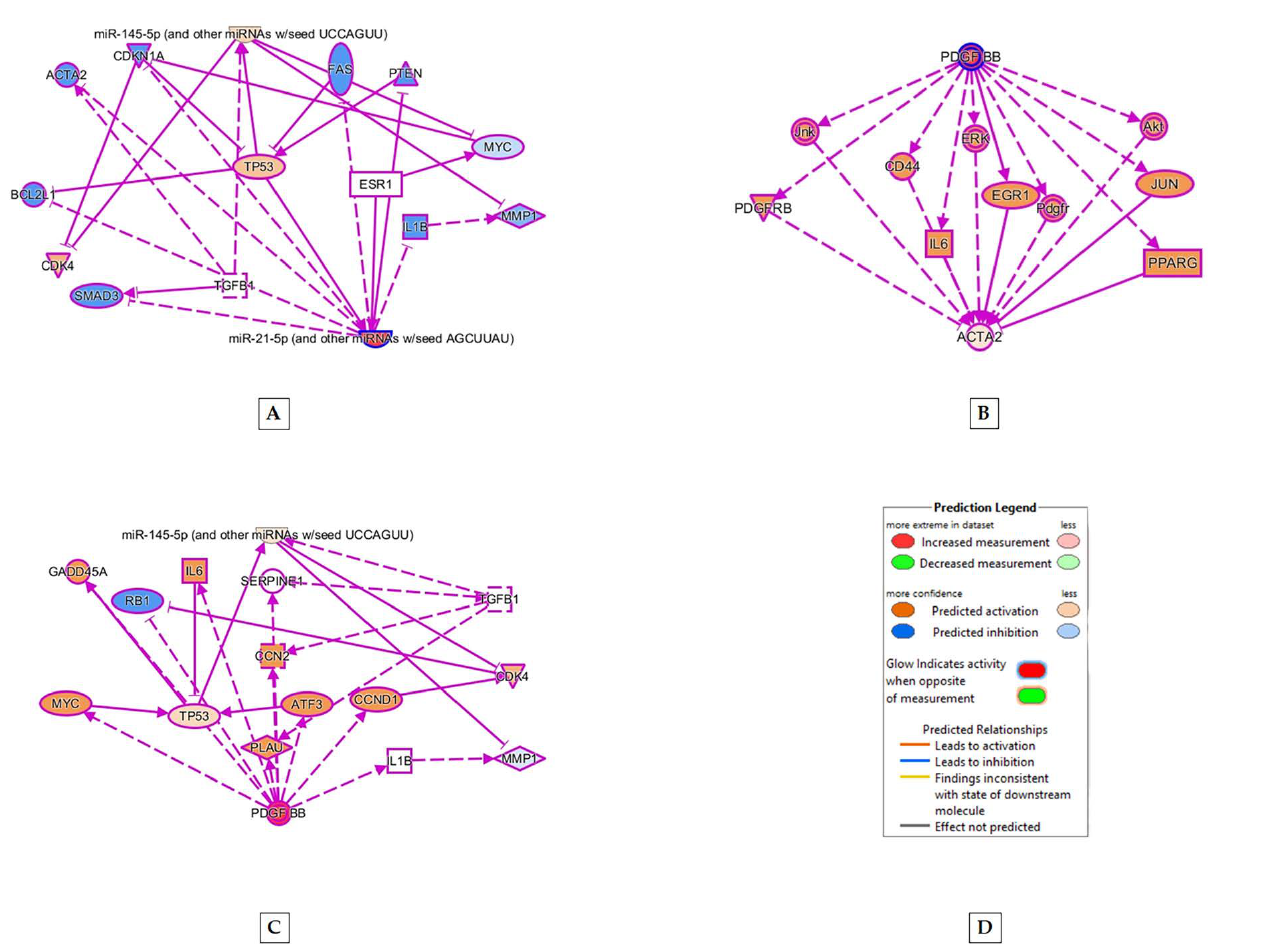
Figure 6. Molecular upregulation and pathway analysis between ( A ) miRNA 21-5p and miRNA 145-5p, ( B ) PDGF and miRNA 145-5p, and ( C ) PDGF-BB and ACTA2 using ingenuity pathway analysis (IPA). ( D ) represents the color code denoting up/downregulation of molecules in the pathways ( A – C ). Pathway ( A ) shows that miRNA 21-5p upregulates miRNA 145-5p. The analysis of ( B ) indicates that PDGF and TGF β 1 independently upregulates miRNA 145-5p. The pathway ( C ) indicates that PDGF-BB upregulates